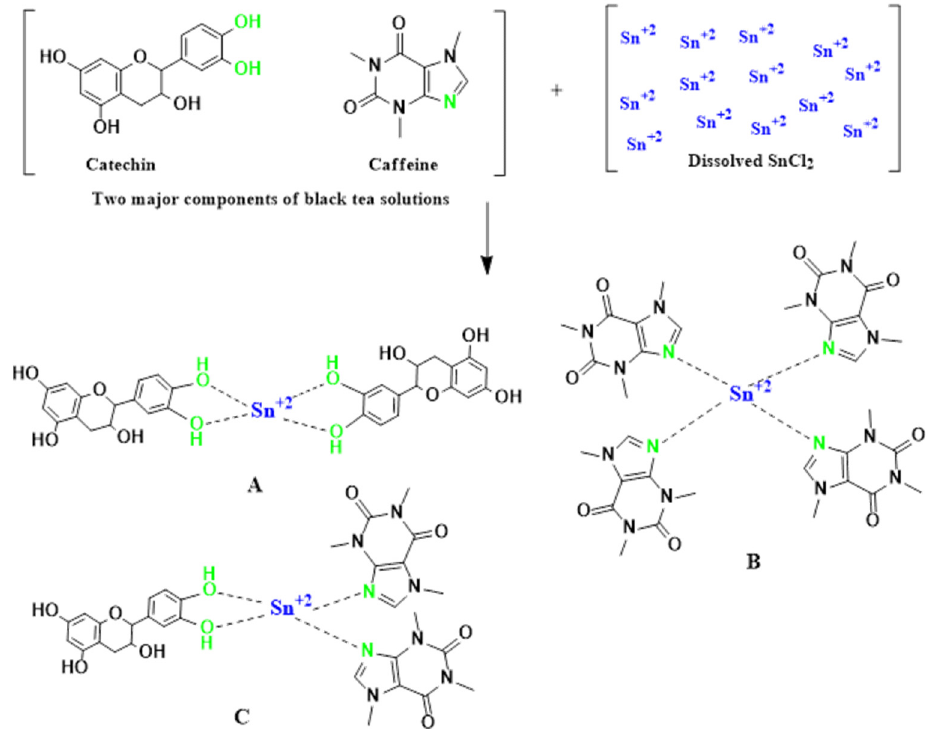
Figure 3. The proposed chemical structure for the Sn 2+ -PPHs metal complex formation mechanism. ( A ) Sn 2+ -catechin metal complex, ( B ) Sn 2+ -caffeine complex, and ( C ) interaction between Sn 2+ and both caffeine and catechin.